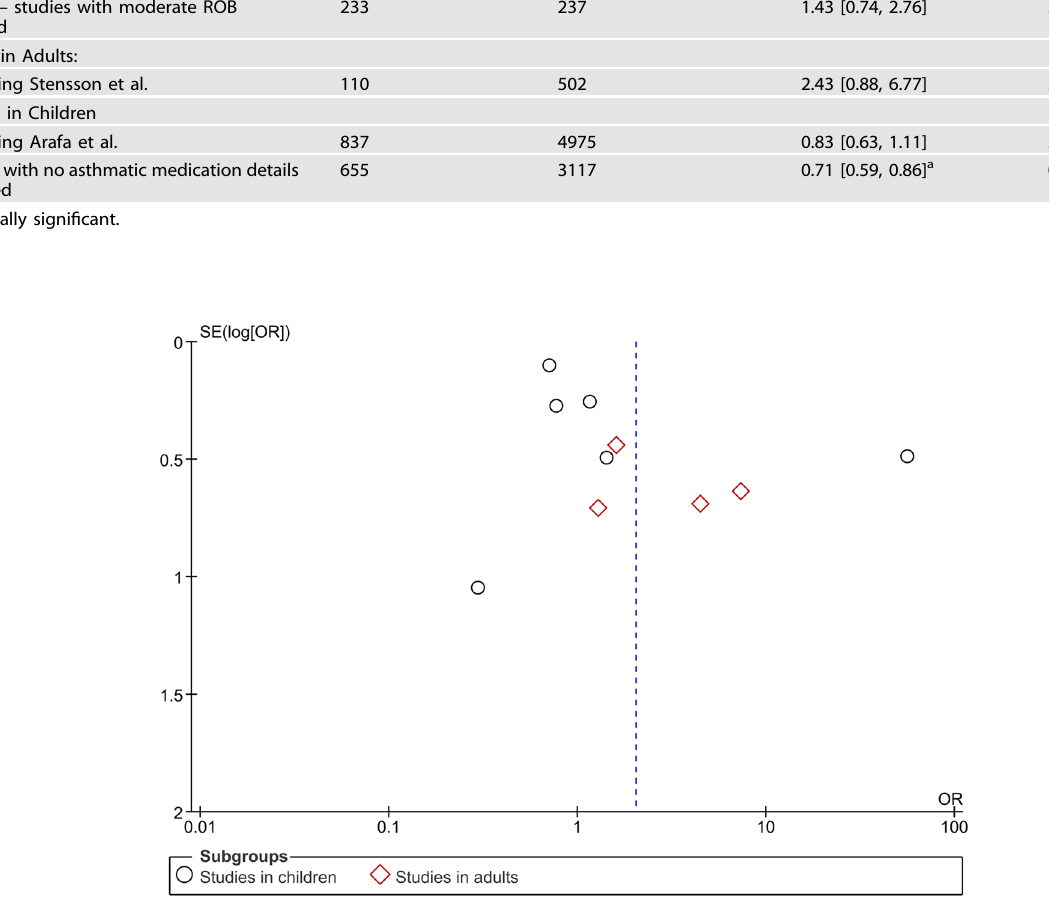
Fig. 4 Funnel plot. Diagram depicting publication bias.